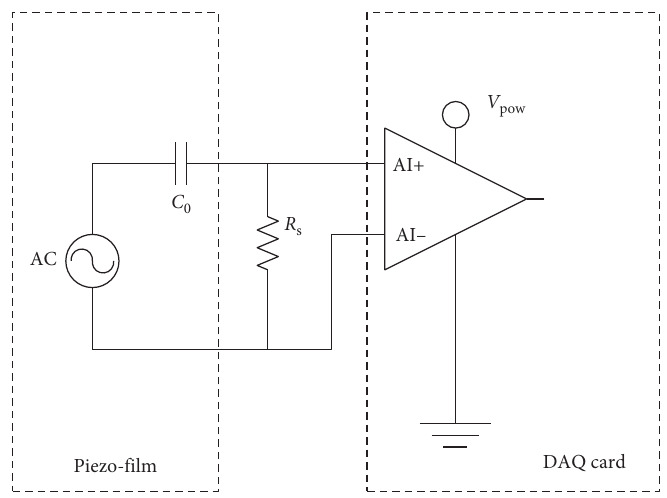
Figure 3: Equivalent circuit of piezo-sensor with DAQ card.